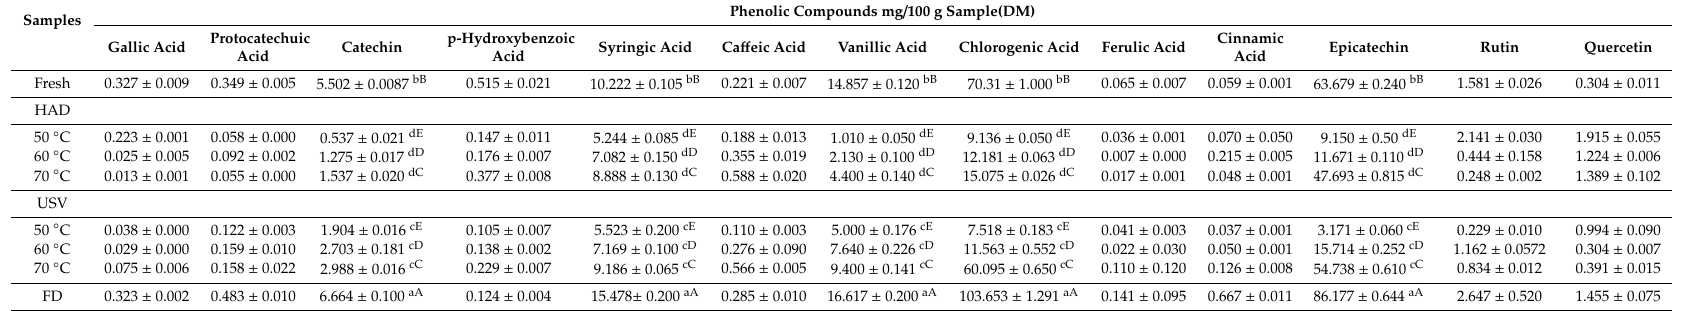
Table 2. E ff ect of the phenolic profile of cherry